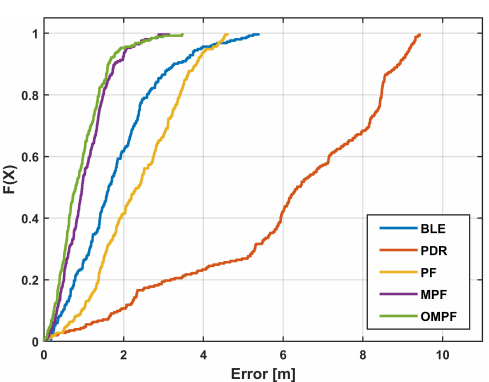
Figure 6: Cumulative error percentages of BLE, PDR, PF, MPF, and